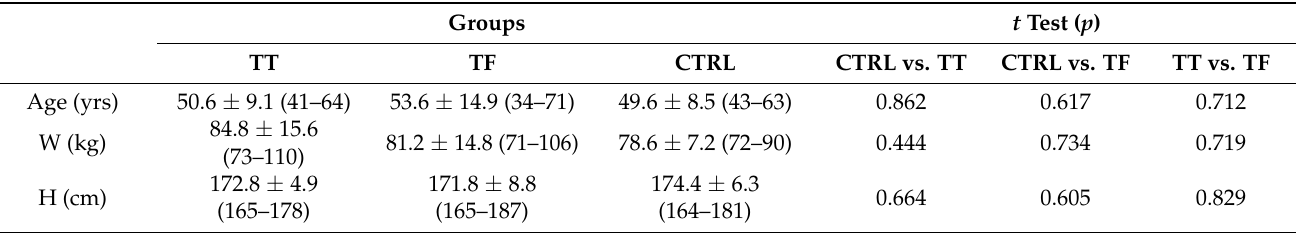
Table 1. Descriptive statistics (mean ± standard deviation and range) of the anthropometric data of all participants.